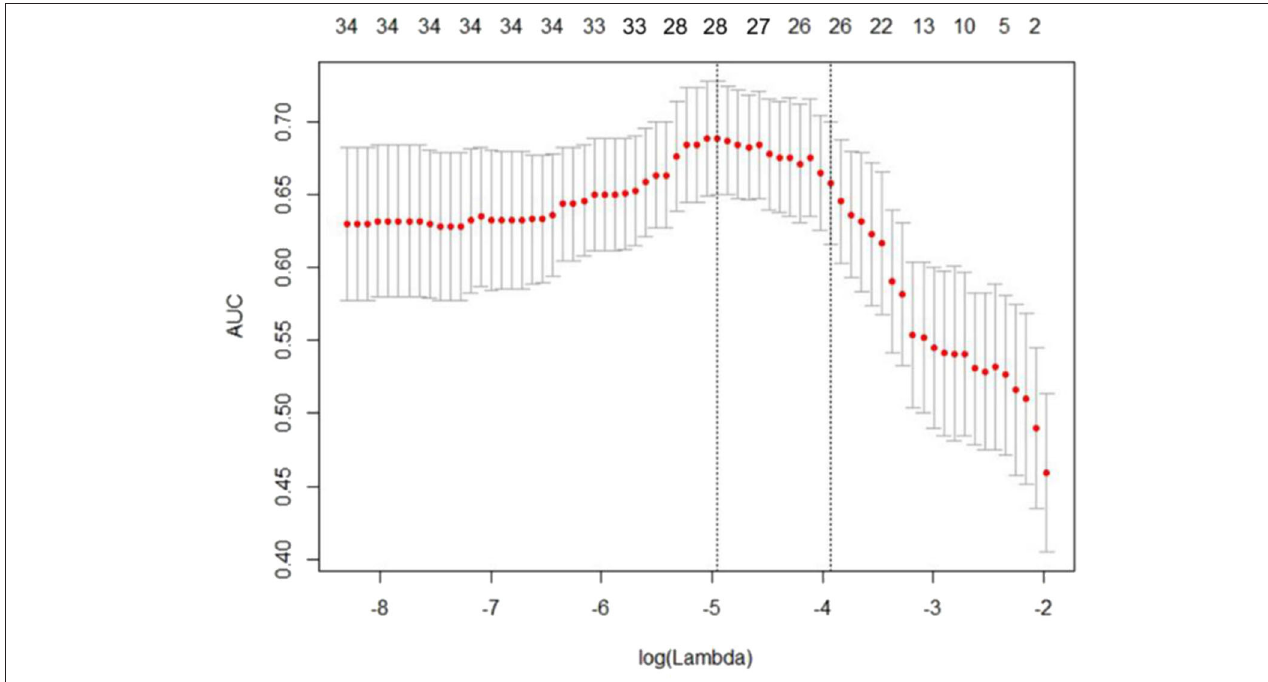
FIGURE 1 | Least absolute shrinkage and selection operator (LASSO) regression analysis uses the minimum standard and a 10-fold cross-validation method. The coefficients of the model are compressed by introducing a penalty adjustment parameter ( λ ) so that the coefficients of the irrelevant variables tend to be zero, and then, the automatic screening of the variables is realized.